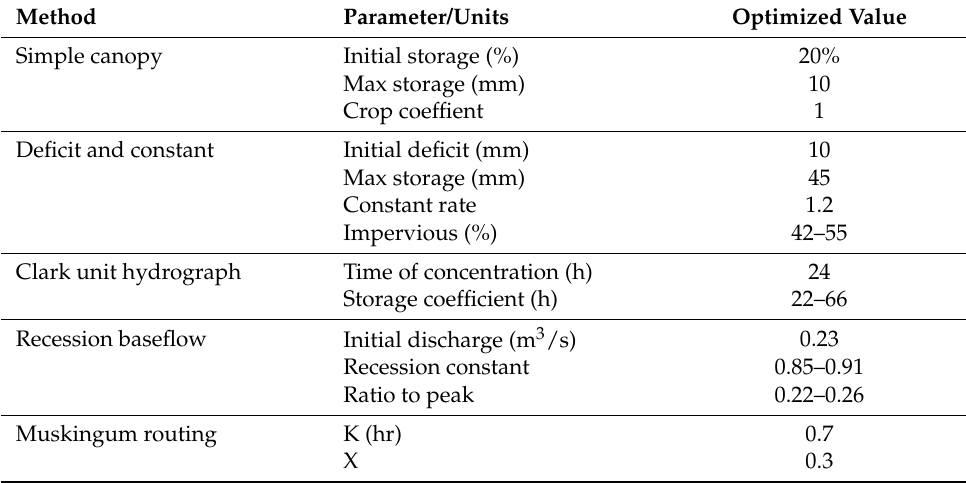
Table 6. Optimized parameters and their values in the HEC-HMS